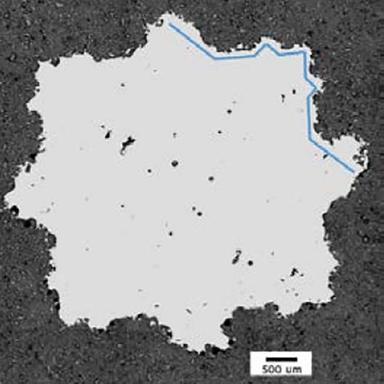
Optical microscope image showing the "as-built" cross section of Koch bar KF3 with an equivalent diameter of 6.01 ± 0.2 mm. Blue insert bars representing regions of KF2 bar are shown for reference. (For interpretation of the references to color in this figure legend, the reader is referred to the web version of this article.)